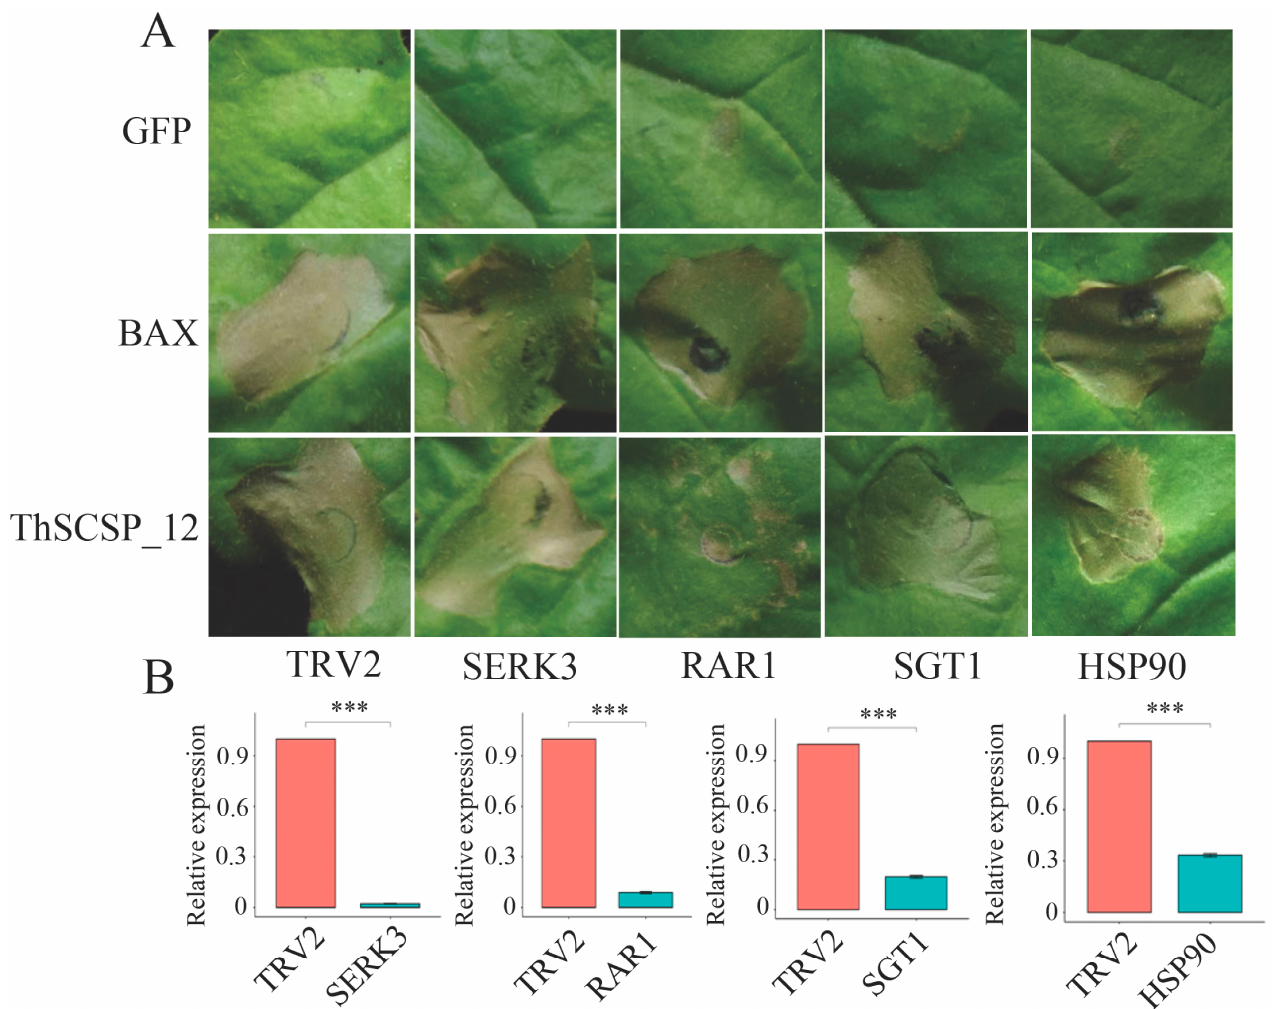
Figure 5. The RAR1 protein is required for cell death induced by ThSCSP_12. ( A ) Representative photographs of ThSCSP_12-induced cell death in silenced Nicotiana benthamiana leaves at 4 days post-inoculation (dpi). At 20 dpi, Agrobacterium tumefaciens carrying ThSCSP_12 was infiltrated into the upper leaves of silenced plants of tobacco rattle virus (TRV) constructs. The control consisted of un-silenced plants. ( B ) The transcript expression levels of RAR1, SGT1, HSP90, and SERK3 in corresponding silenced plants were analyzed by qRT-PCR. The constitutively expressed gene NbActin was used as internal reference. Statistical analysis was performed by one-way ANOVA, followed by Tukey’s multiple comparison test. Error bars are the standard deviation (SD) of three biological replicates (*** p < 0.001).